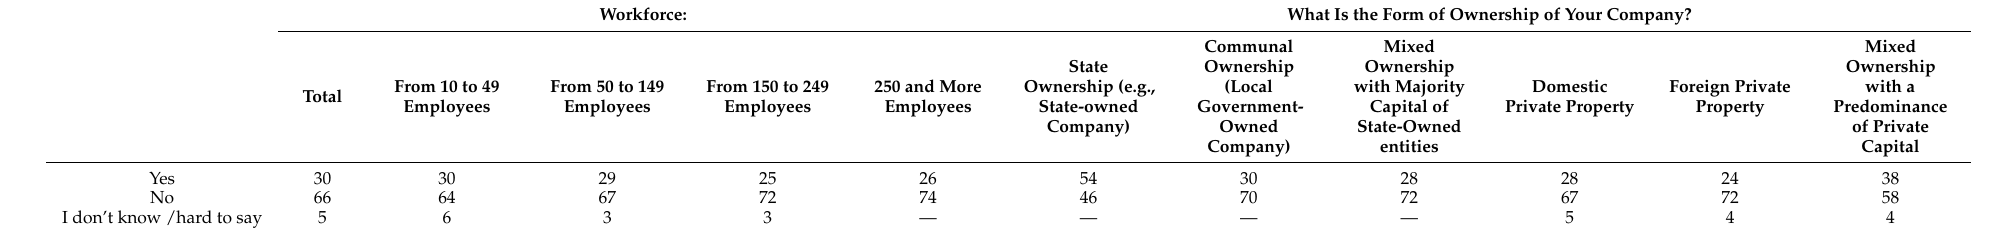
Table 2. The countries of the old EU use slogans about global warming to promote their companies related to renewable energy and thus weaken the Polish energy sector and lead to the collapse of Polish mines (in percentage